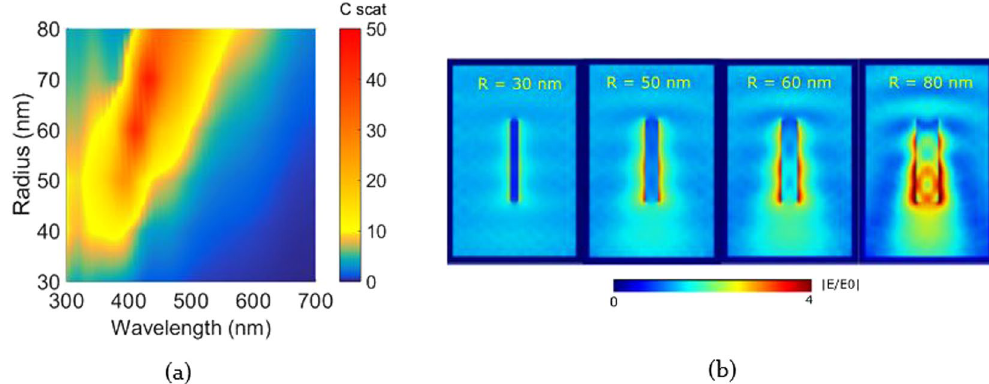
Figure 3. ( a ) Scattering cross section spectra of a 600 nm long ZnO nanorod in air calculated for different radii ( b ) near field observed at light wavelength of 500 nm for radii 30, 50, 60 and 80